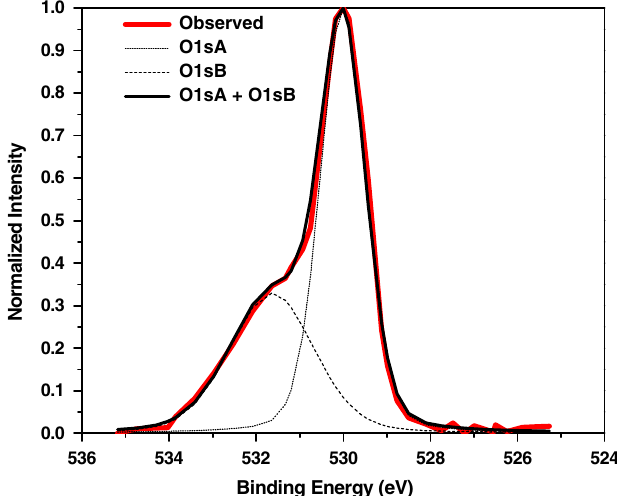
FIG. 7. Normalized XPS spectrum of oxygen 1 s for an un- treated Nb sample.